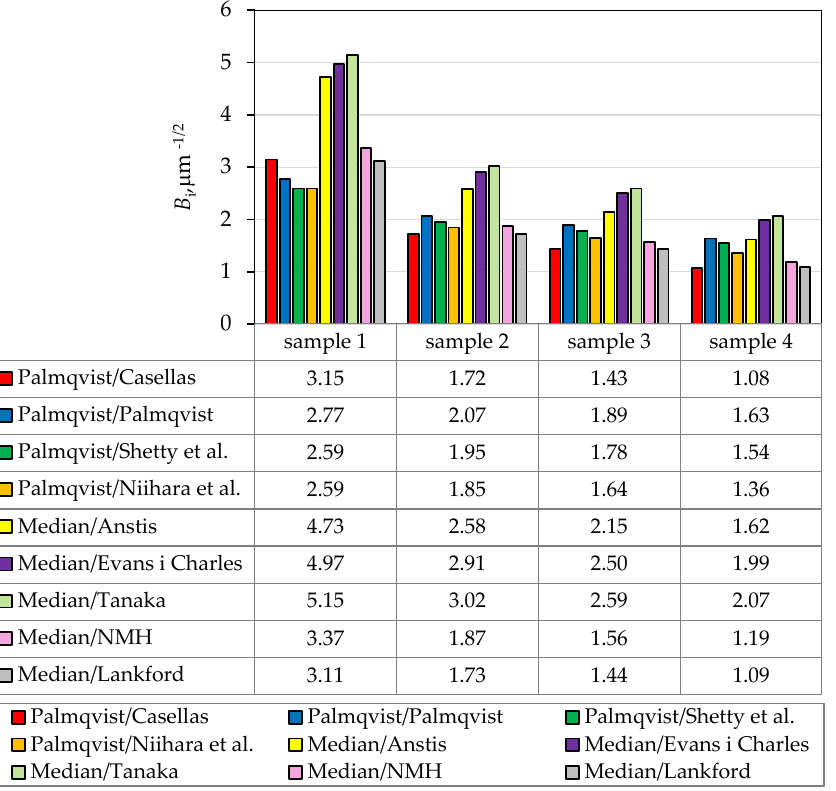
Figure 14. Comparison of brittleness index ( B i , µ m − 1 / 2 ) values for di ff erent crack types, models and all samples (NMH-Niihara, Morena and Hasselman).